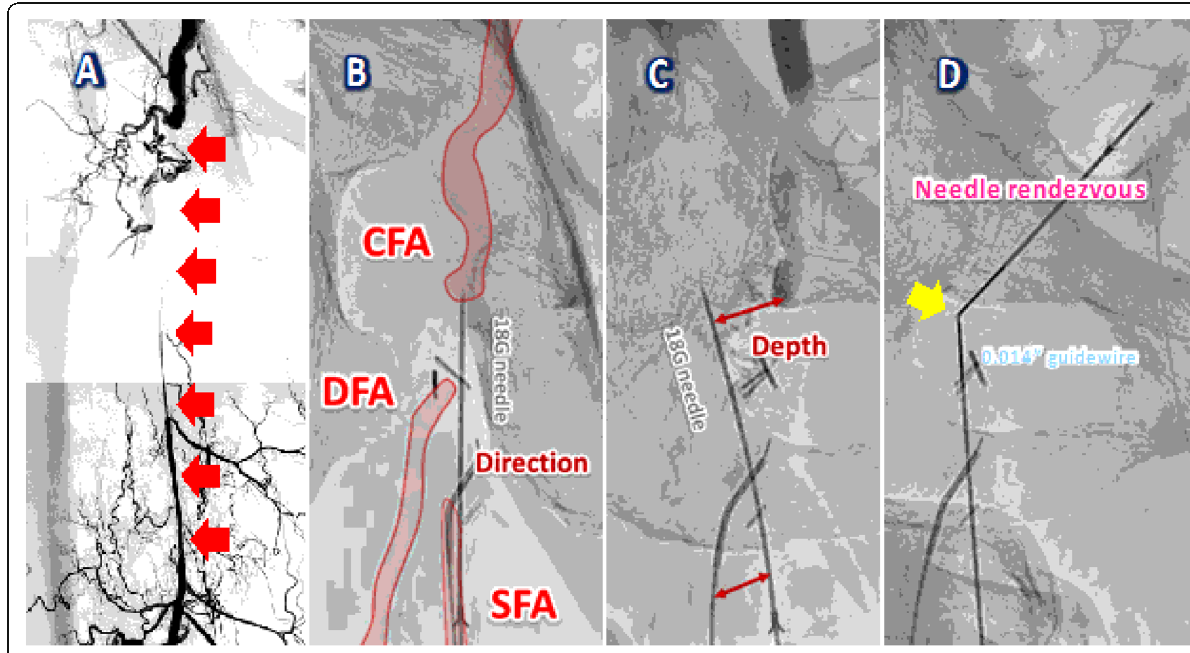
Fig. 1 Angiography and Needle rendezvous technique. A . Digital subtraction angiography showed the overall lesion (red arrows). B and C . Confirming the correct direction and depth in contralateral ( B ) and ipsilateral ( C ) views. The first 18-gauge needle was used to puncture from the proximal thigh into the body below the right CFA. D . The second 18-gauge needle was used to puncture from the right groin through the right CFA into the first needle tip (yellow arrow). A 0.014-in. guidewire was manipulated carefully to thread two needles ( “ needle rendezvous ”